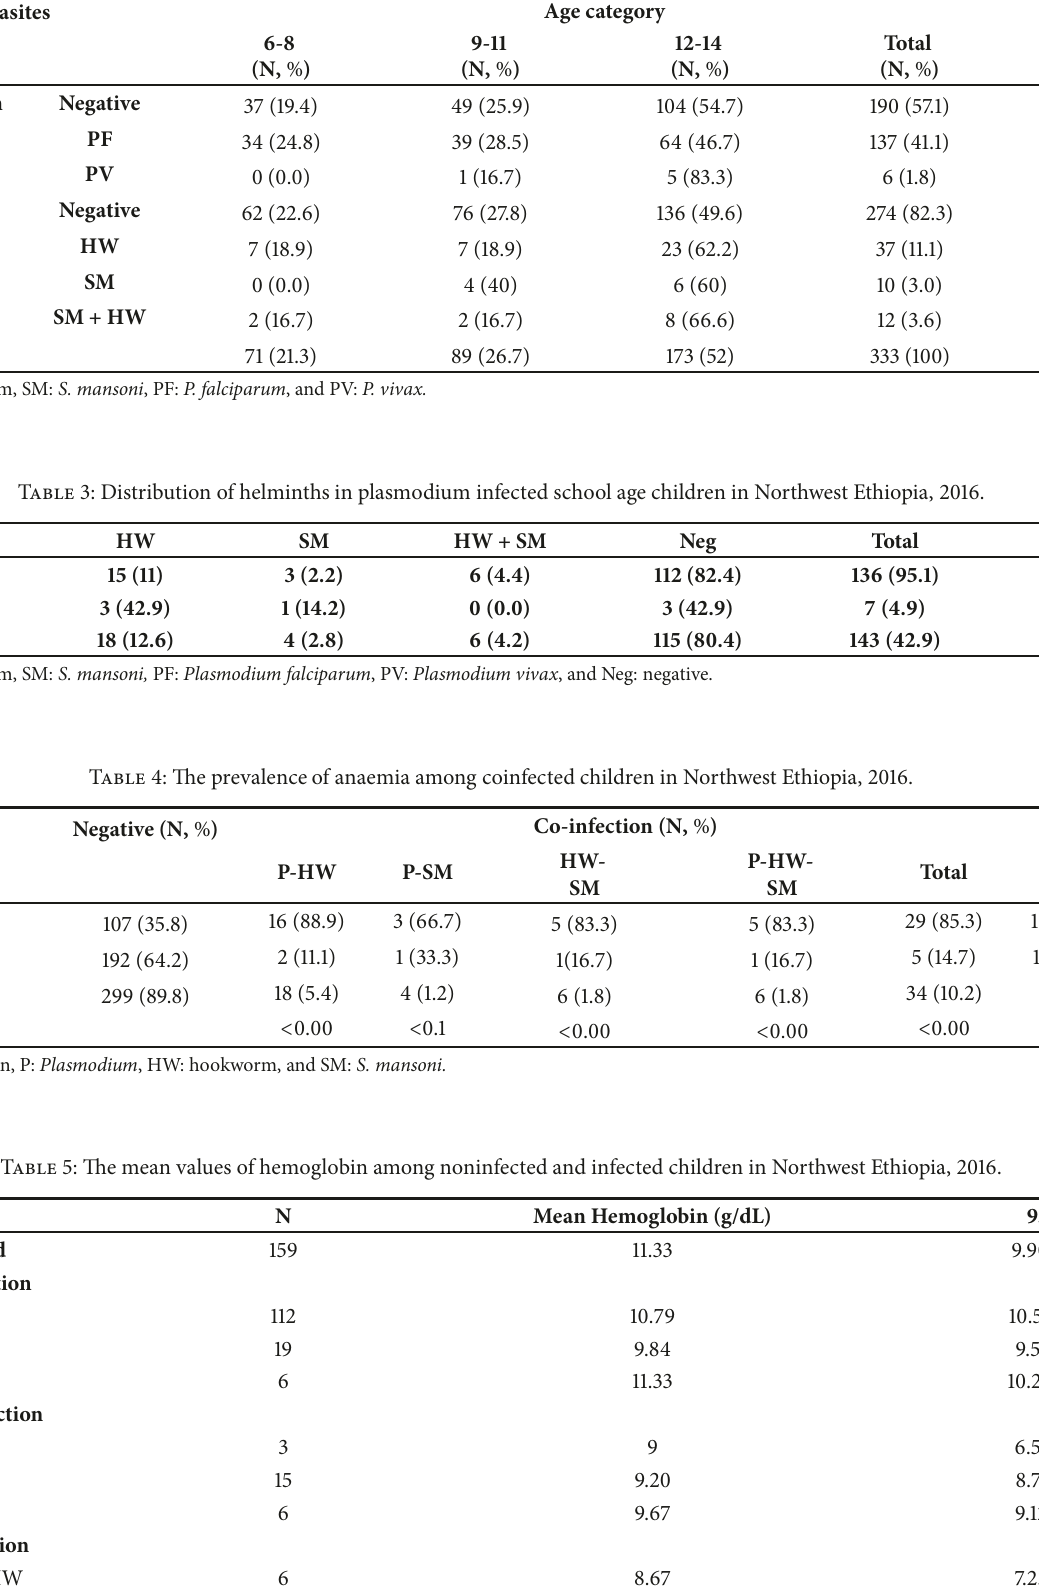
Table 2: Distribution of plasmodium and helminths infection among school age children in Northwest Ethiopia, 2016. Types of parasites